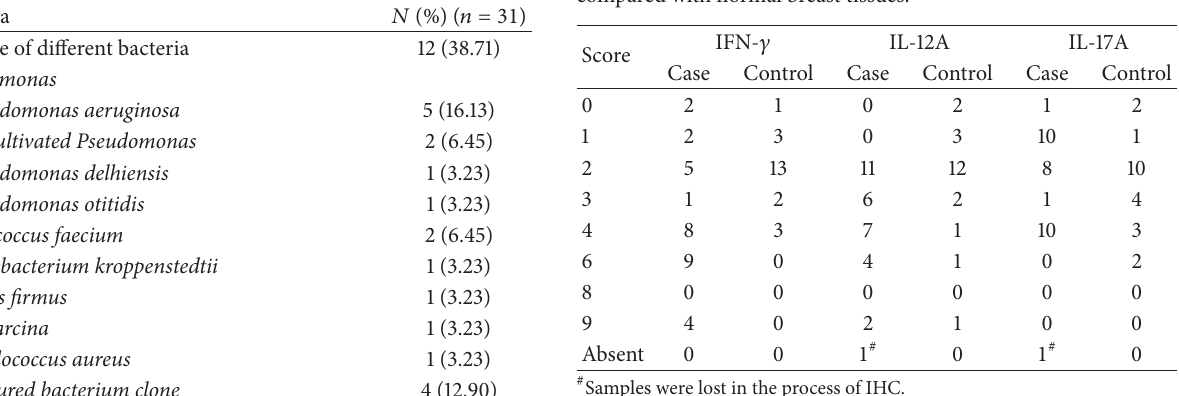
# Samples were lost in the process of IHC. Table 7: The correlationship of IFN- 𝛾 , IL-12A, and IL-17A expres- sion in PDM compared with normal breast tissues.